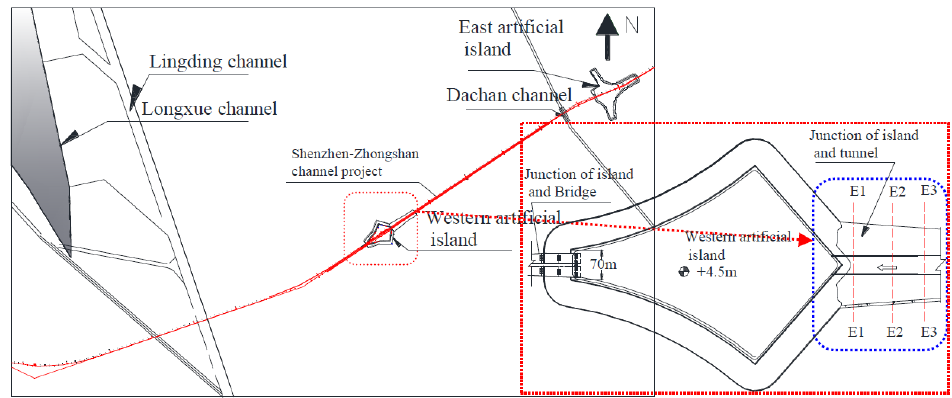
Figure 1. Layout plan of the project.